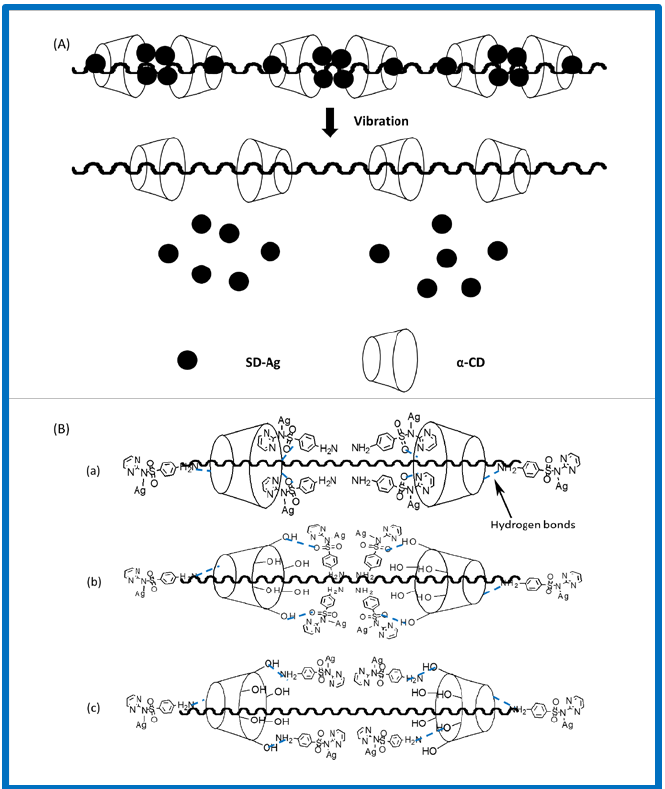
Figure 6. The mechanism of PR loading SD-Ag: ( A ) Drug release model; ( B ) combination through ( a ) N ··· H ··· N hydrogen bonds between –NH 2 in SD-Ag, O ··· H ··· O hydrogen bonds between –OH in α -cyclodextrin (CD) and O=S=O in SD-Ag and partial inclusion of pyrimidine rings by α -CD cavity; ( b ) N–H–N hydrogen bonds between –NH 2 in SD-Ag and O ··· H ··· O hydrogen bonds between–OH in α -CD and O=S=O in SD-Ag; ( c ) O ··· H ··· N hydrogen bonds between –OH in α -CD and –NH